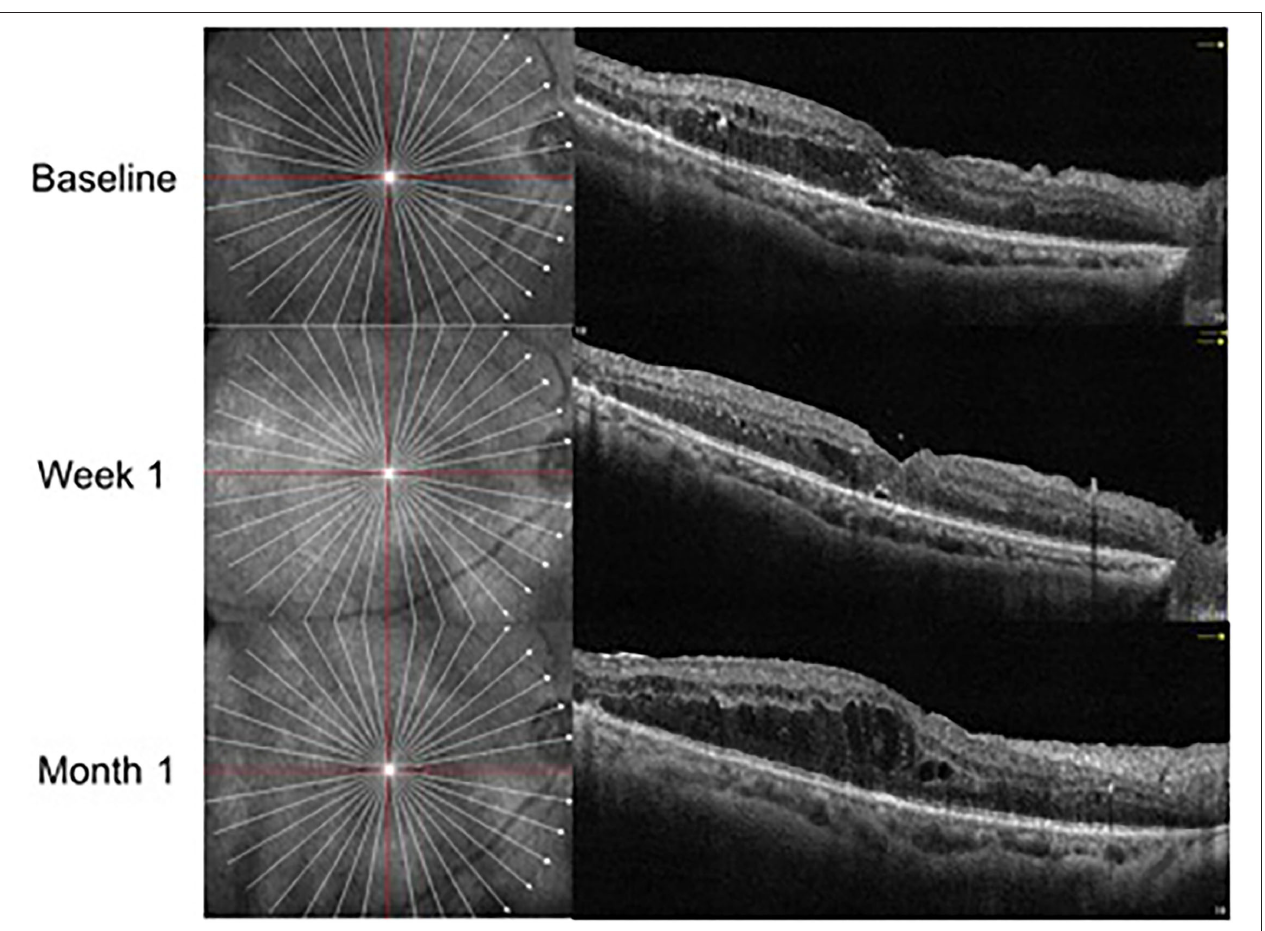
FIGURE 1 | OCT follow-up visit of the same patient with anti-VEGF